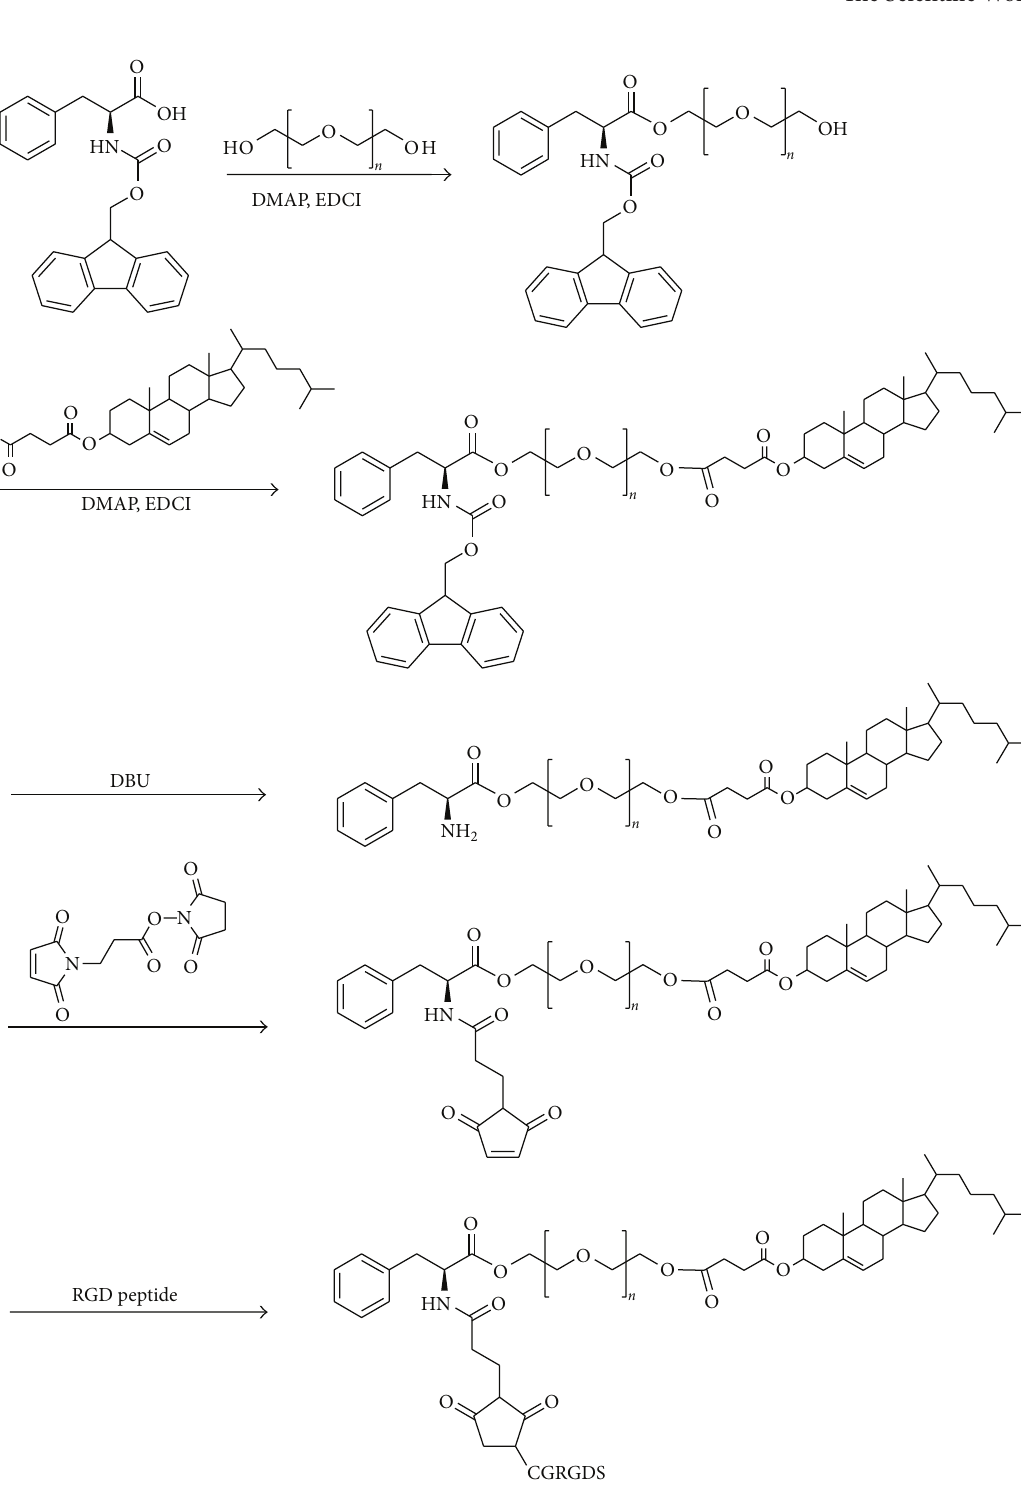
Scheme 2: Synthetic route of RGD-PEG-Chol